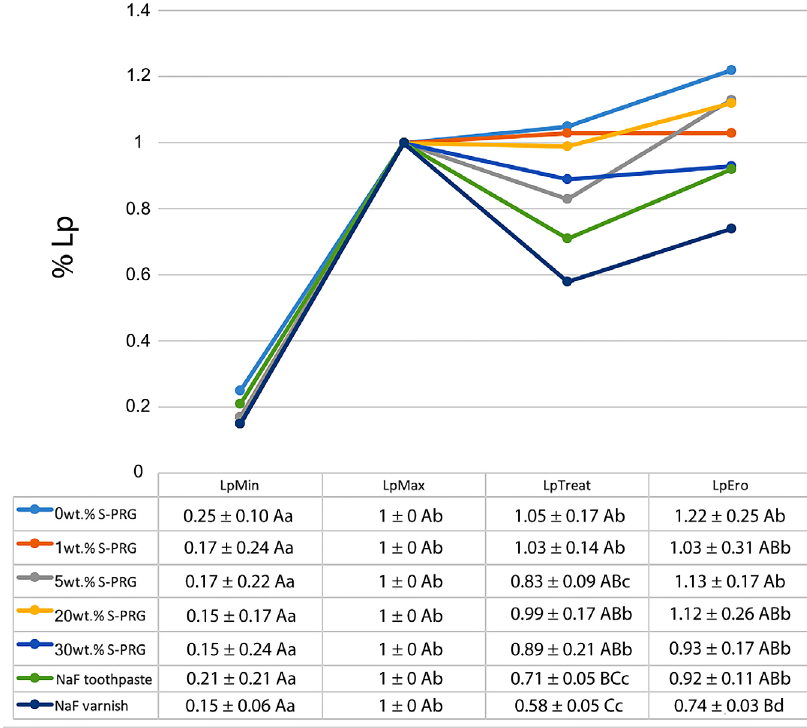
Figure 1- Mean ± standard deviation of the percentage of hydraulic conductance (% Lp) for each tested